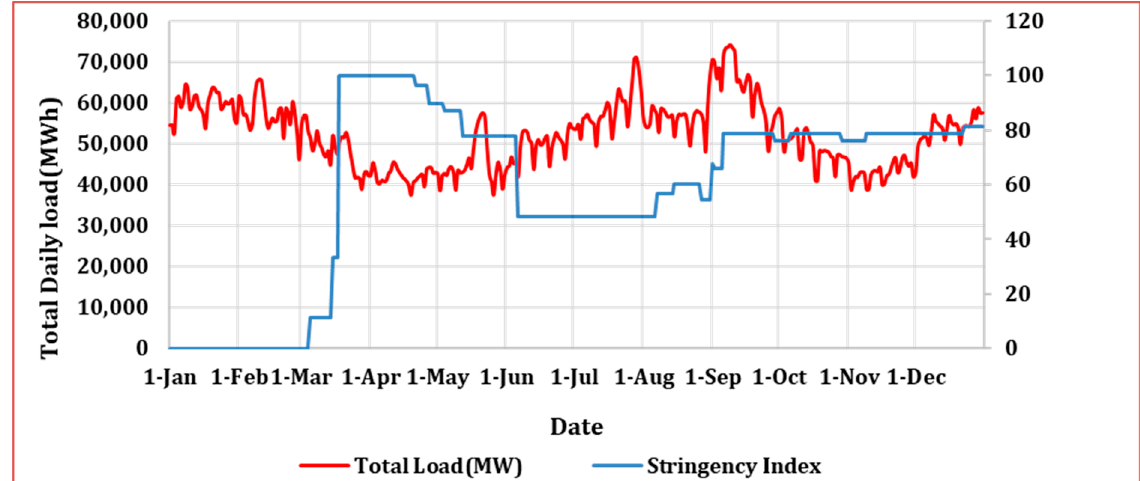
Figure 5. Daily electricity consumption with SX for the year 2020.